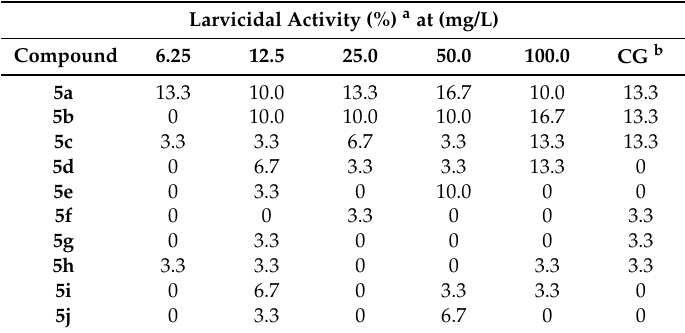
Table 2. The growth inhibitory activities to Mythimna separata Walker of 5a – c .